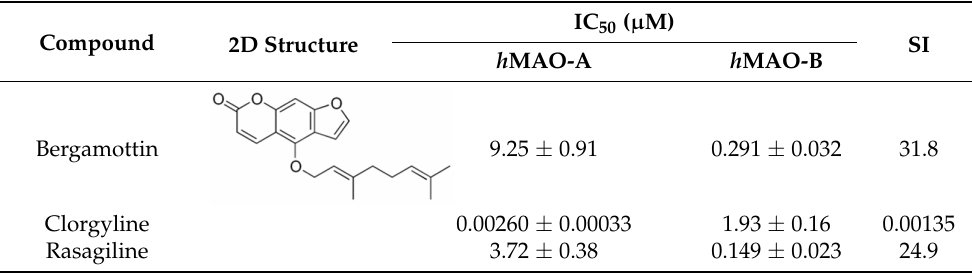
Table 2. h MAOs inhibitory activities of bergamottin and the reference MAO inhibitors rasagiline ( h MAO-B) clorgyline for ( h